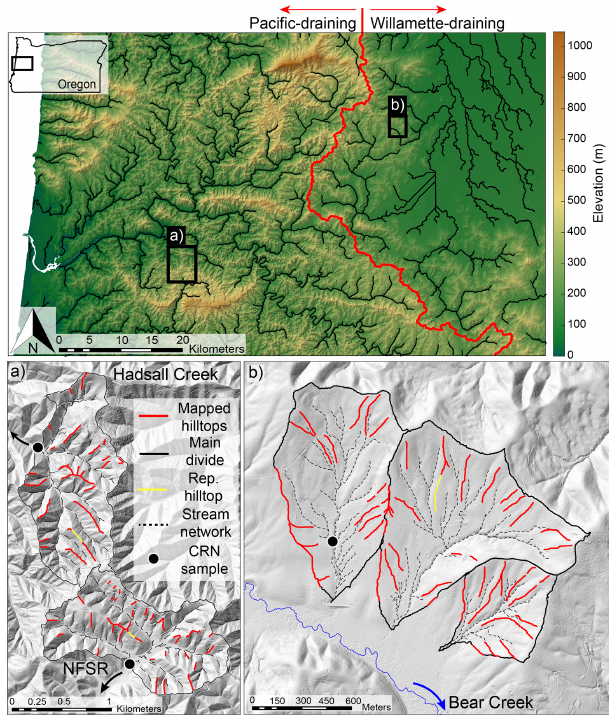
Figure 1. Oregon Coast Range study sites. Note the drainage divide (red) between catchments that flow directly to the Pacific Ocean and those that flow east into the Willamette River, which then flows northward to the Columbia River. (a) Hadsall Creek and the North Fork Smith River (NFSR). (b) The three catchments that flow to Bear Creek. Arrows in (a, b) denote river flow direction. Repre- sentative (Rep.) hilltop selected so that it approximates the average curvature for the catchment when compared to curvature measure- ments taken for all